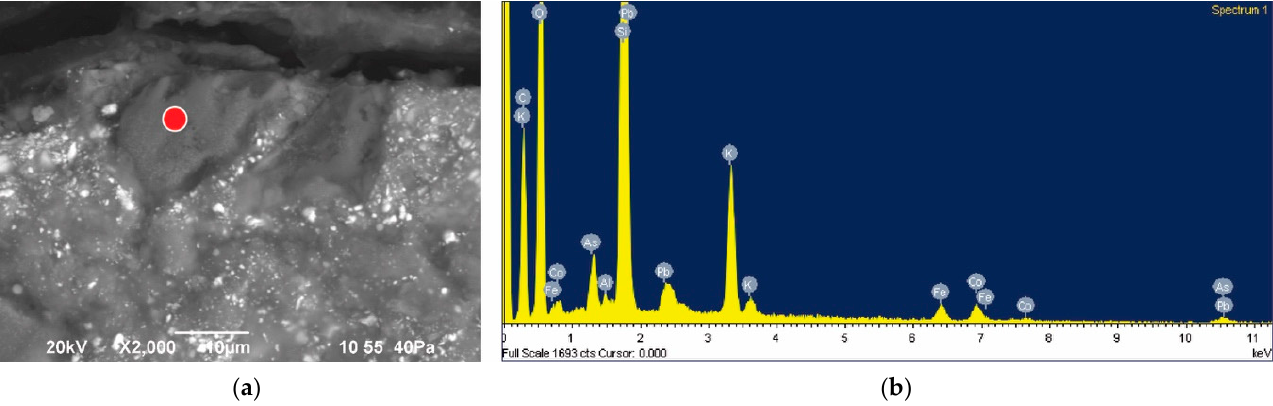
Figure 9. ( a ) SEM image of a smalt particle. The spot where the microanalysis with EDX was made is marked with a red dot. ( b ) EDX spectrum showing lead, potassium, cobalt, arsenic, iron, and aluminum signals. Images by LADiPA-COL-MICH.